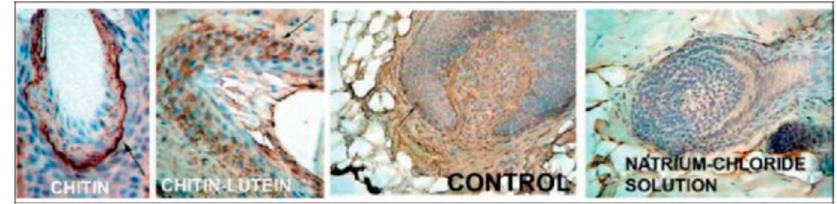
Figure 7. Faster stem cells reproduction onto hair treated by chitin nanofibrils binding lutein [78].